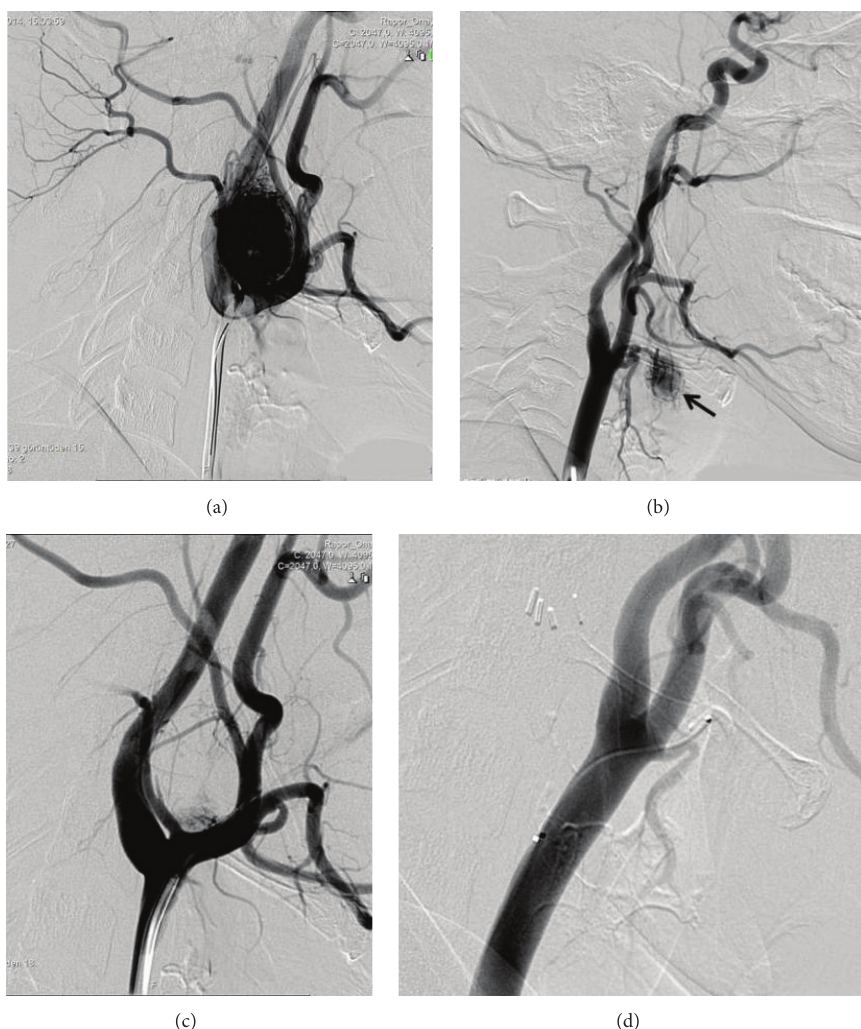
Figure 5: A lateral cervical angiogram from the left common carotid artery demonstrates the intense blush at the carotid bifurcation corresponding to the carotid body paraganglioma (a). Right common carotid artery lateral cervical angiogram shows significant tumor vascularity (arrow) at the larynx (b). Principal arterial feeder to the tumor from superior thyroid artery. Significant reduction is seen in tumor vascularity after embolization of the ascending pharyngeal and proximal occipital artery with polyvinyl alcohol particles measuring 255 to 350 (c). Superselective catheterization of the superior thyroid artery after embolization shows complete devascularization